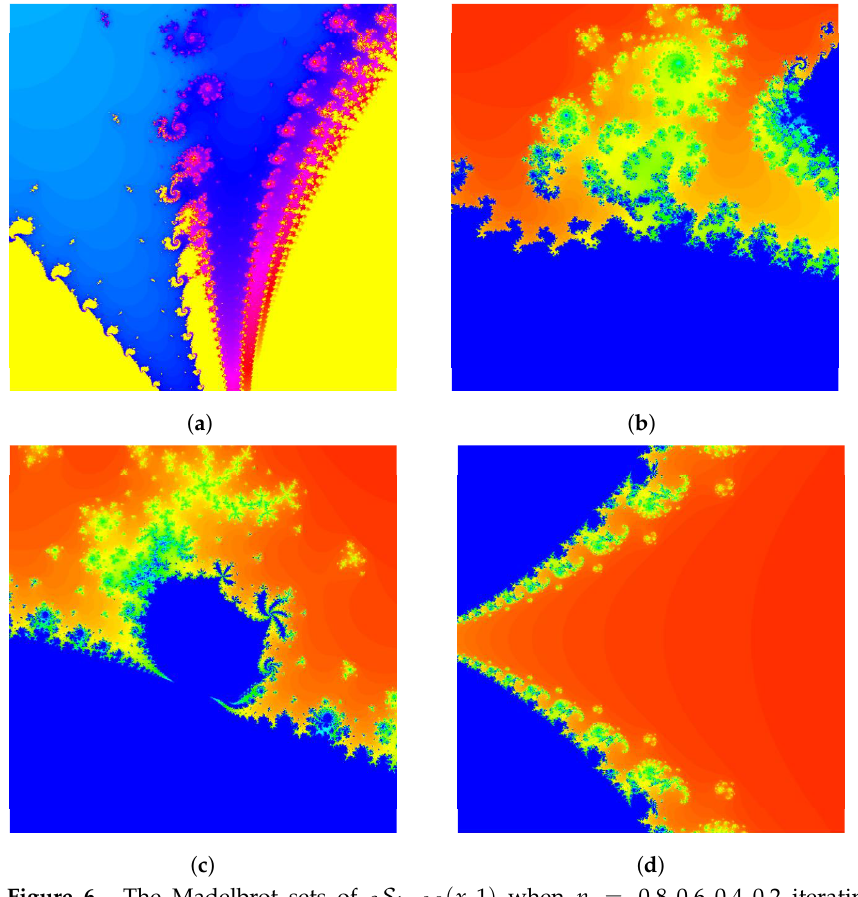
Figure 6. The Madelbrot sets of S S 4, p ,0.9 ( x ,1 ) when p = 0.8,0.6,0.4,0.2 iterating 128-times. ( a ) S S 4,0.8,0.9 ( x ,1 ) ; ( b ) S S 4,0.6,0.9 ( x ,1 ) ; ( c ) S S 4,0.4,0.9 ( x ,1 ) ; ( d ) S S 4,0.2,0.9 ( x ,1 )